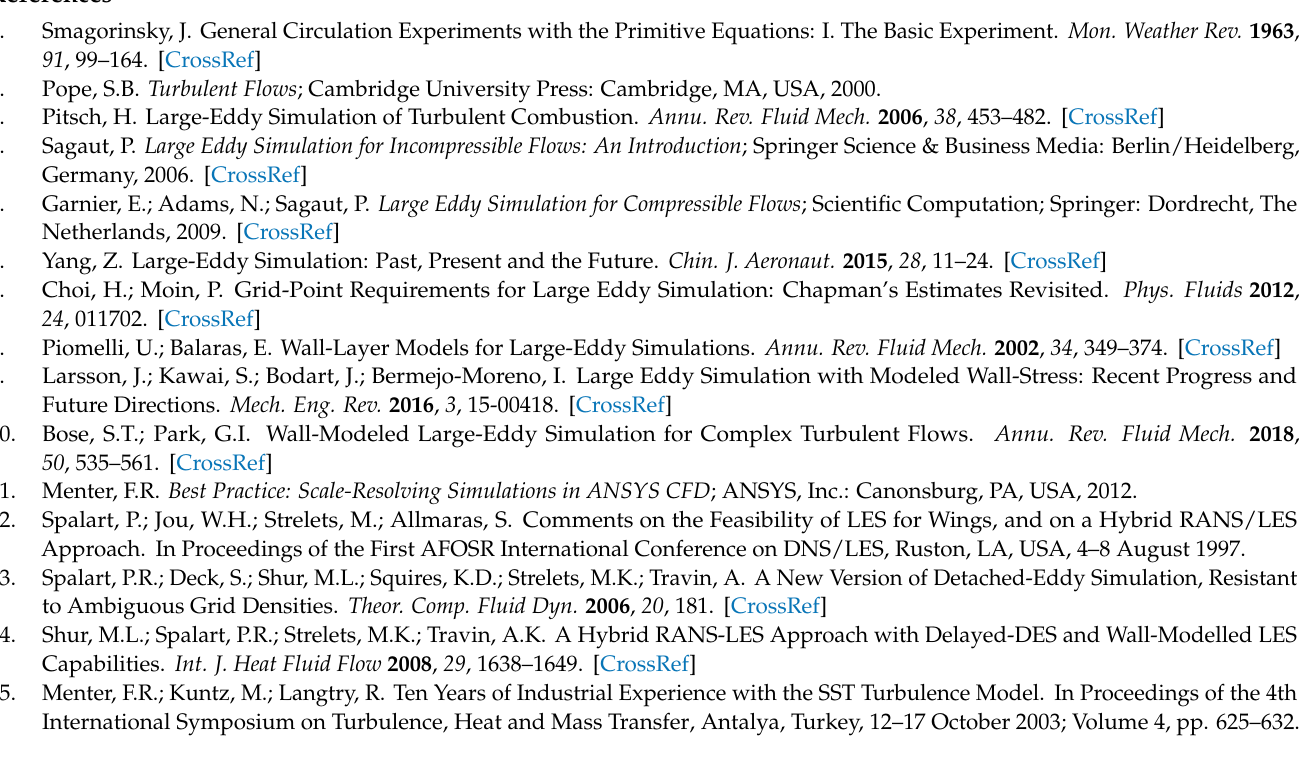
In terms of vortex description, SST-DES can only simulate vortices induced by